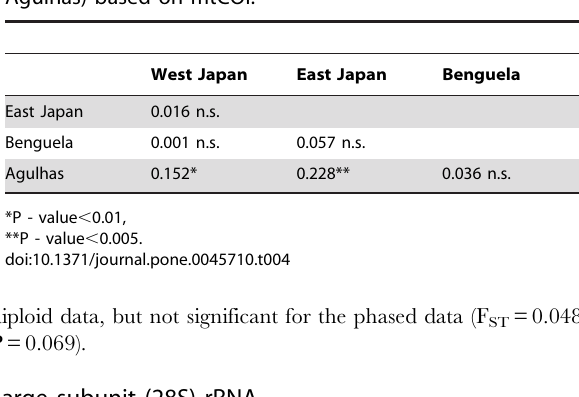
Table 4. F ST distances between populations of C. sinicus (West and East Japan) and C. agulhensis (Benguela and Agulhas) based on mtCOI.